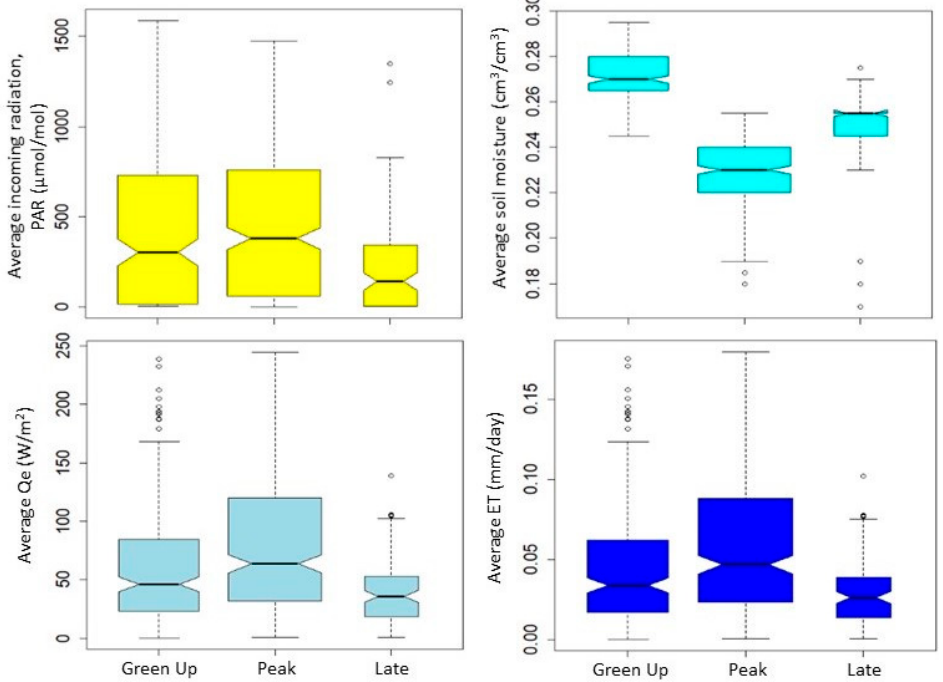
Figure 9. Boxplots showing the seasonal progression of measured, non-gapfilled: daily averaged incoming PAR, daily averaged latent heat flux (Q e ), daily averaged soil moisture at top 10 cm and daily averaged evapotranspiration at Bonsai during the growing season.